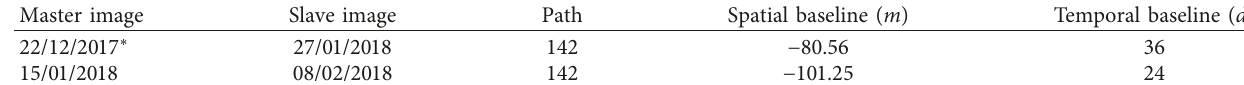
Table 3: Parameters of interferograms for detecting the subsidence areas.